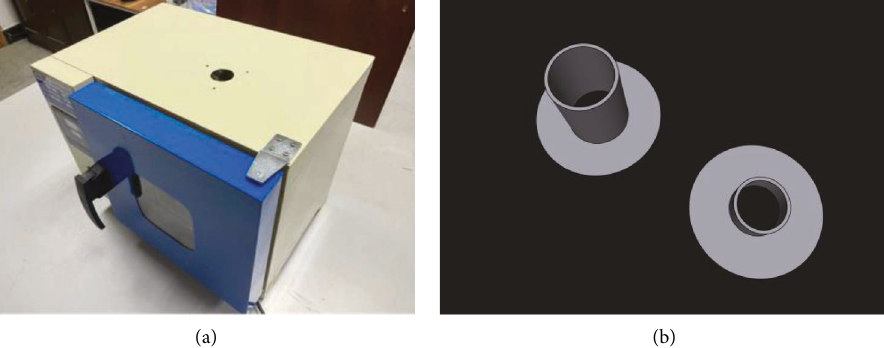
Figure 1: The modified seed germination thermostat. (a) The seed germination thermostat. (b) The top protective cover.